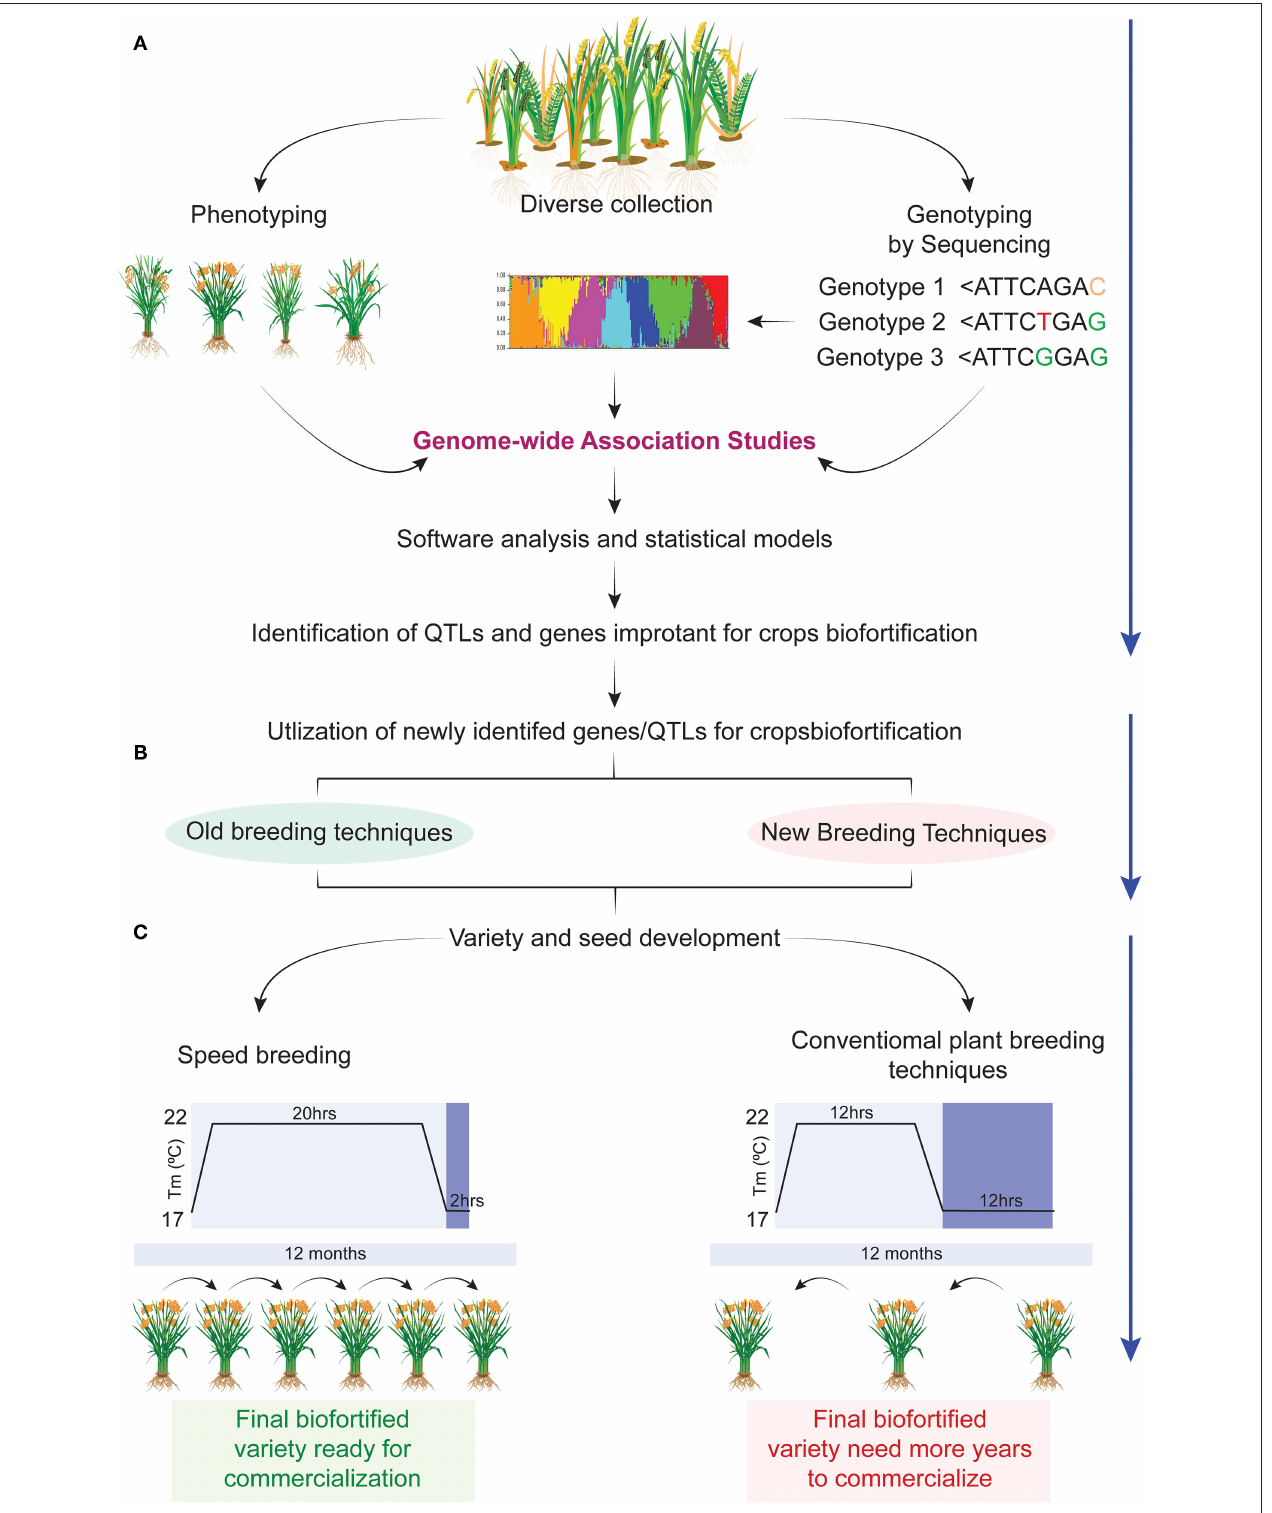
FIGURE 3 | Speedy development of biofortified crops using next generation technologies. (A) Diverse collection of germplasm, its phenotyping and genotyping for nutrient profiling at various locations followed by genome wide association studies (GWAS) for identification of candidate genes involved in the mobility,